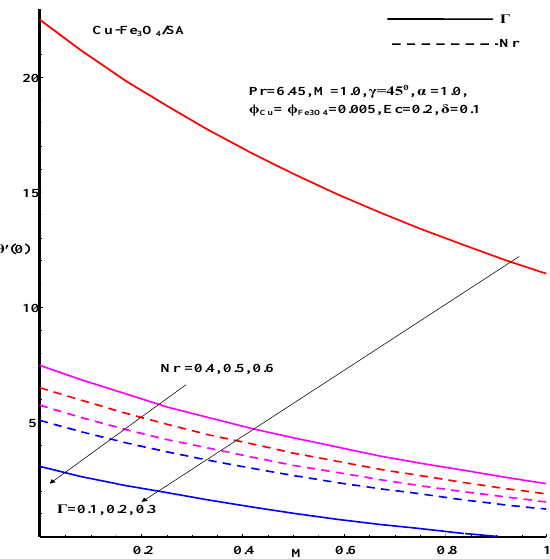
Figure 13. Effect of Casson and radiation parameters on Nussult